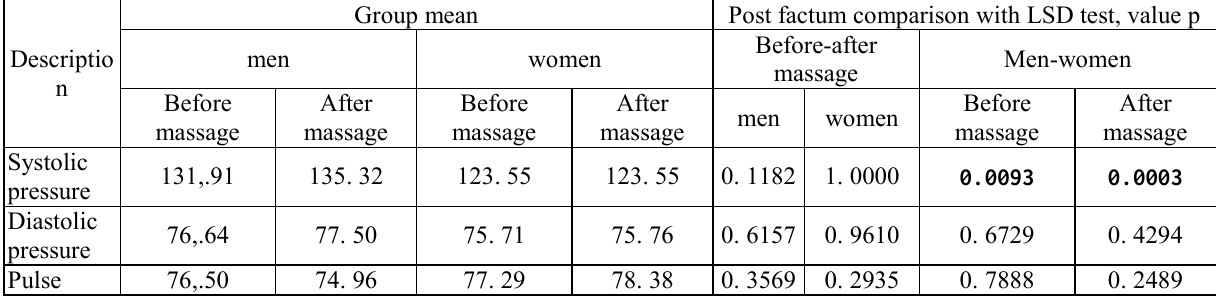
Arithmetic mean and degree of probability for LSD tests (post factum test of the least significant differences) by criteria: sex and multiplication factor.